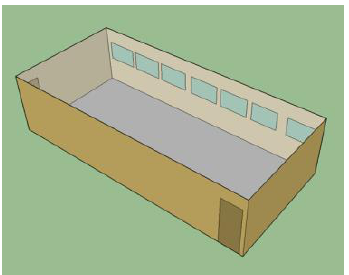
Figure 7: gbXML model is visualized in Sketchup software where ceiling has been deleted for better indoor visualization.